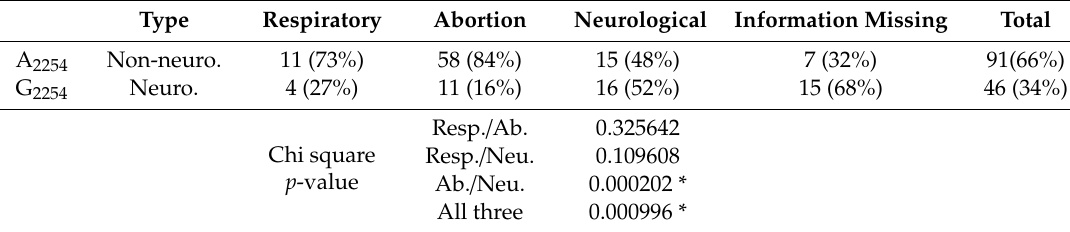
Table 5. ORF30 2254 mutation according to disease from EHV-1 isolates (2009 to 2018). Type Respiratory Abortion Neurological Information Missing